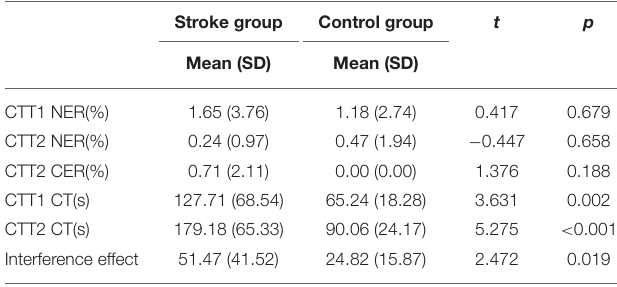
TABLE 5 | The error rates and response times in the color trail test.